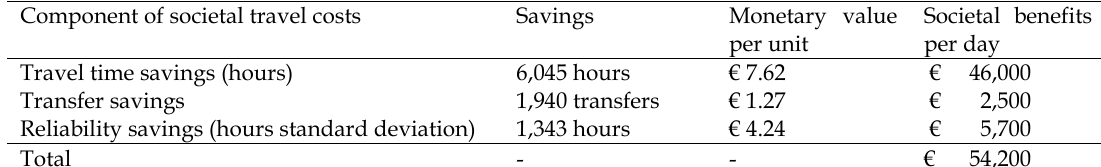
Travel time, transfer and reliability savings translated into monetary values, using Value of Time, Value of Reliability and Value of Transfer (weekdays 7am to 7pm) Component of societal travel costs